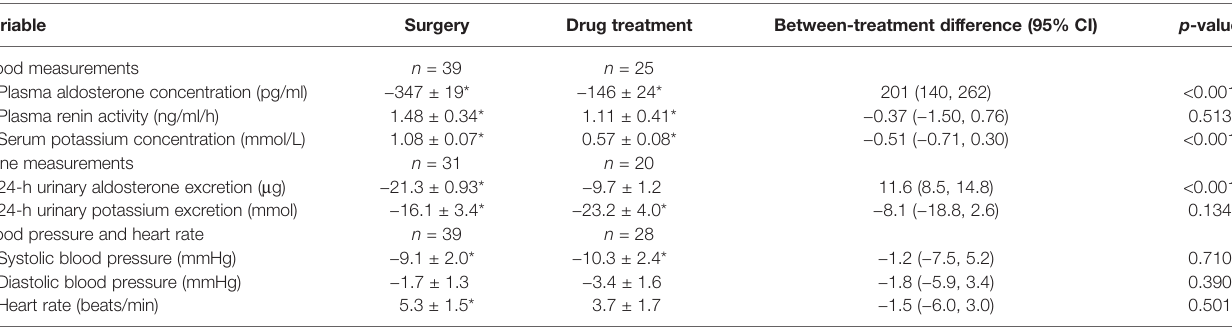
TABLE 3 | Changes in blood and urine biochemical measurements and in blood pressure and heart rate during follow-up.